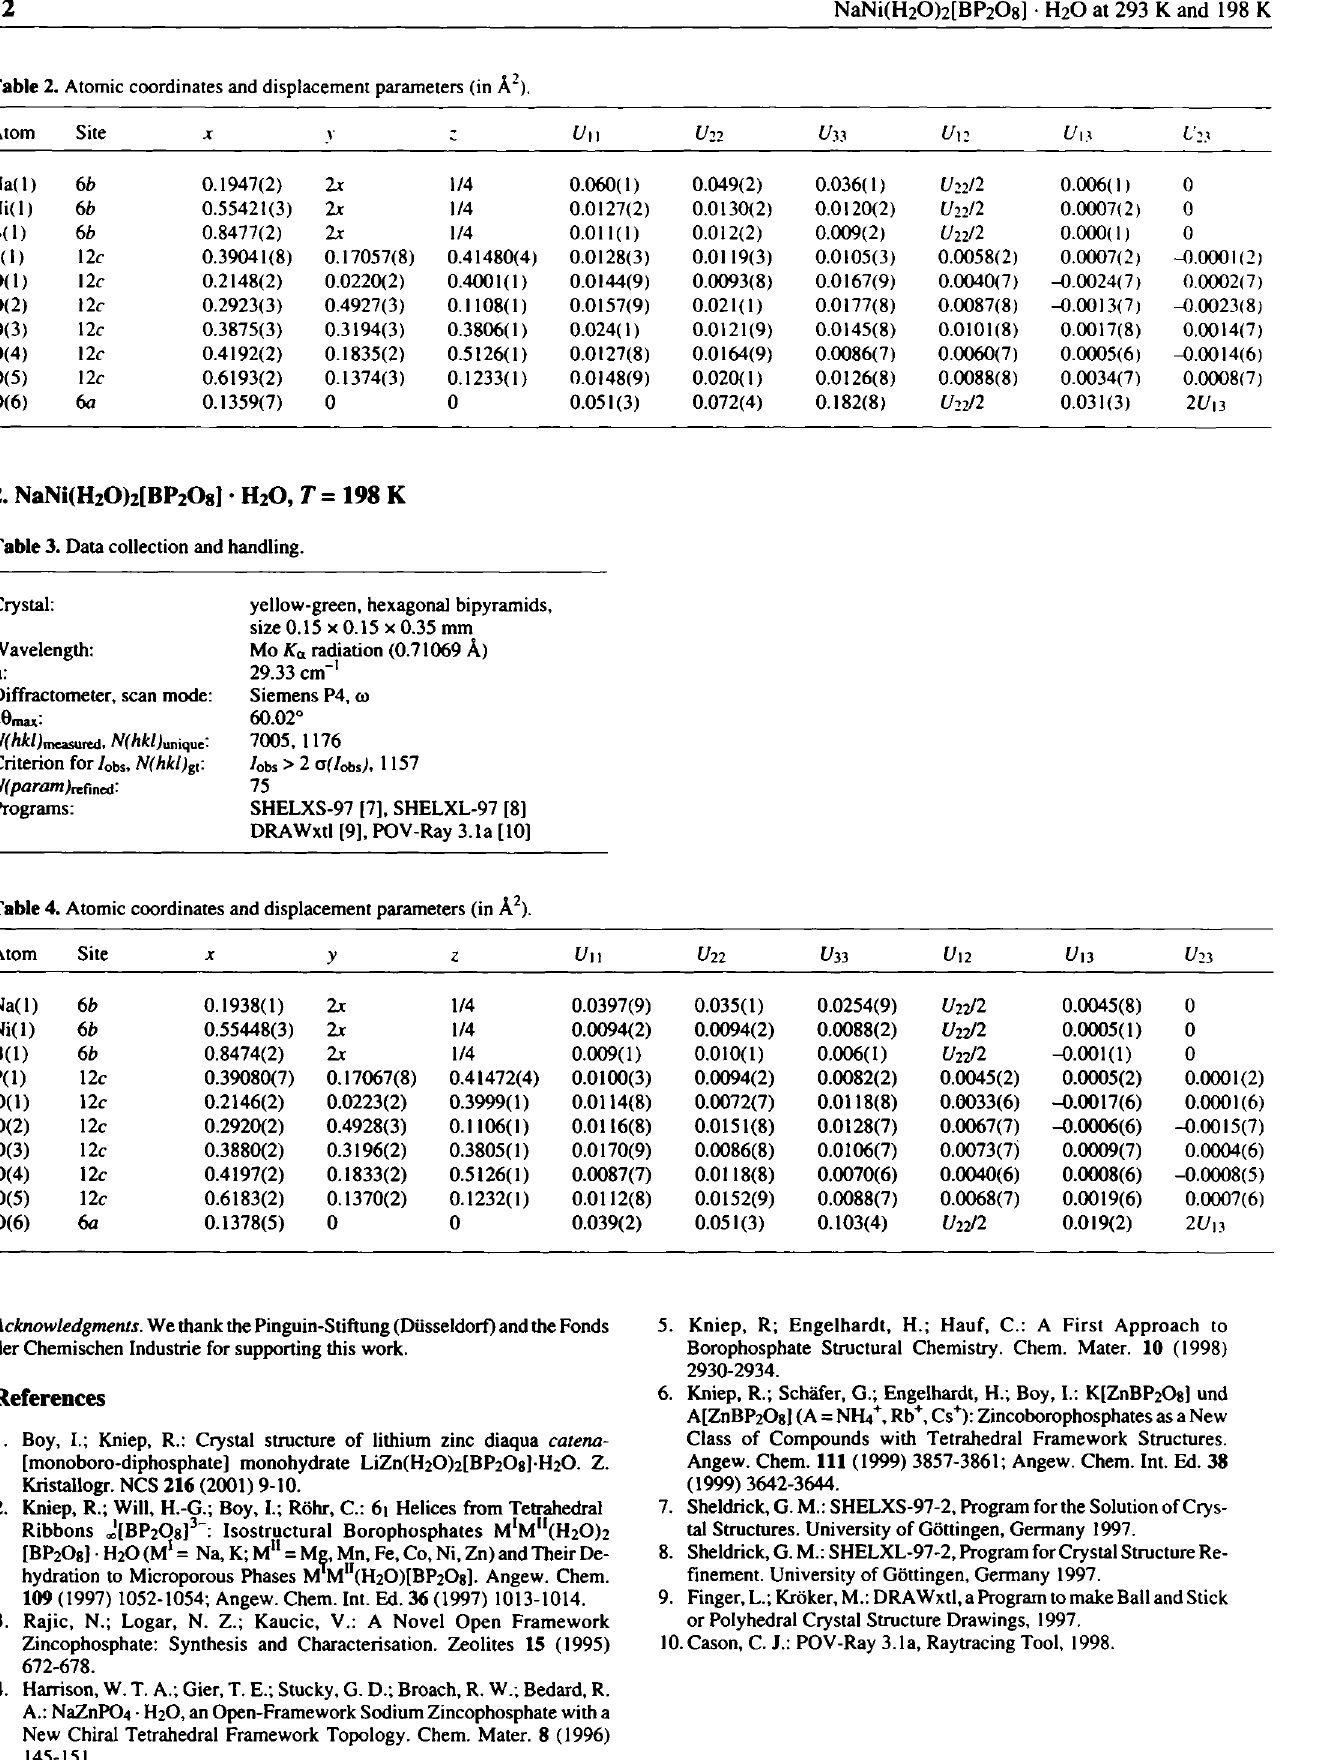
Table 3. Data collection and handling.